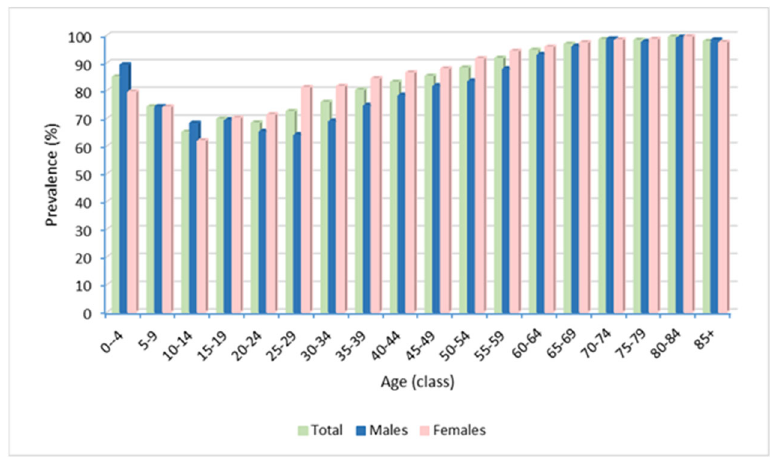
Figure 1. Prevalence of use of all therapeutic categories by age and sex in 2018. Overall, the prevalence was significantly higher in females than males (87.7% vs. 82.6%, p < 0.0001), and in adults (84.7% vs. 77.2%, p < 0.0001), including those aged 20–69 years (89.2% vs. 81.4%, p < 0.0001). Conversely, a higher prevalence rate was